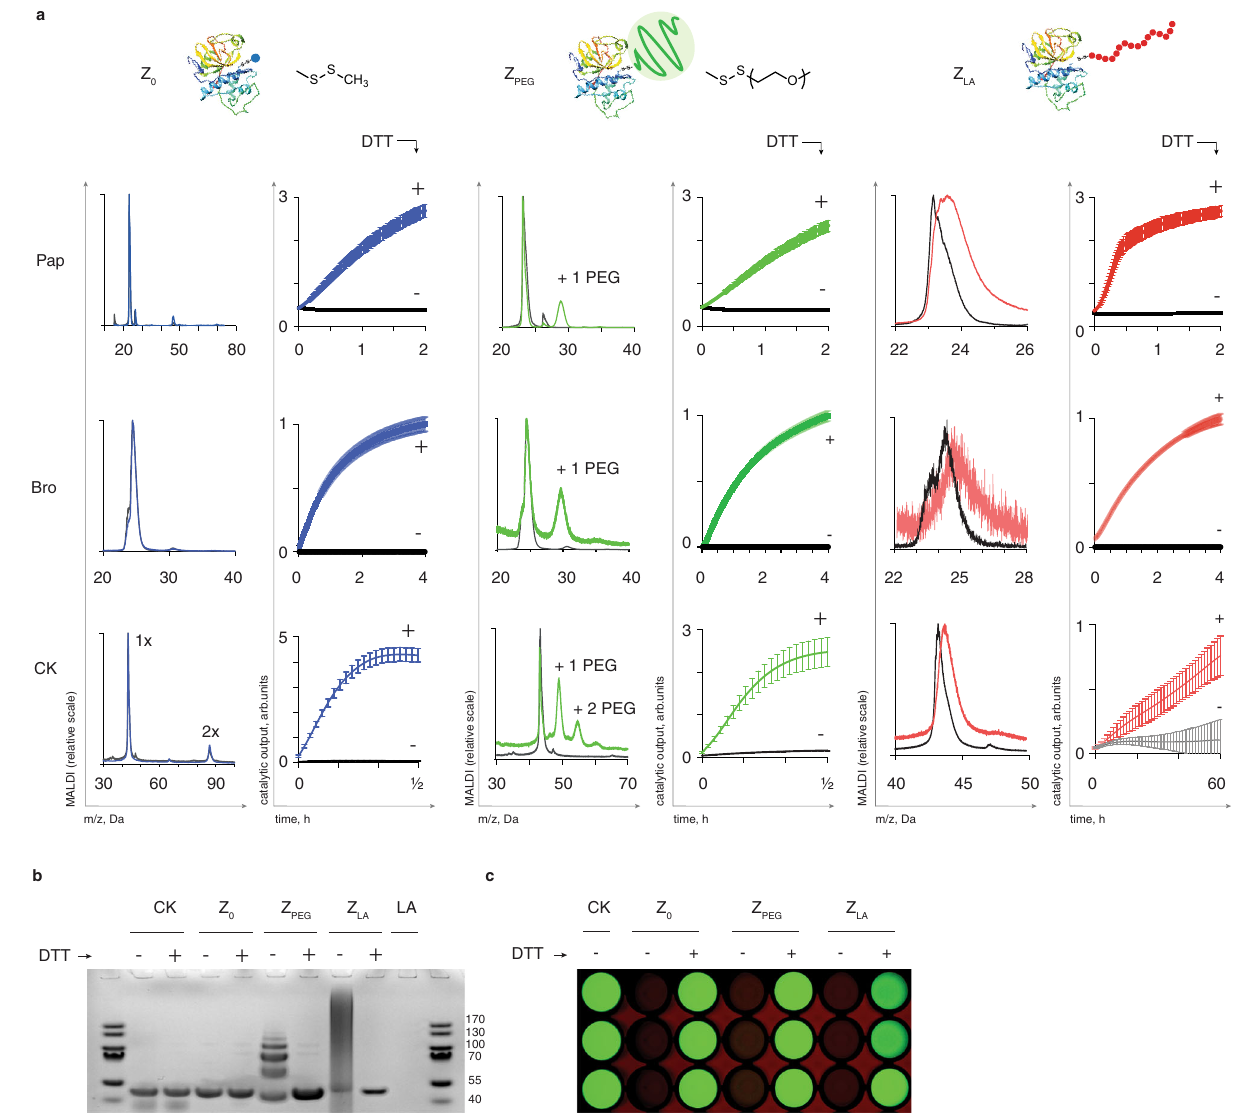
Fig. 3 | Design and characterization of zymogens for cysteinome. a Schematic illustration of the zymogens design, the chemical formulas of the corresponding disul fi des, the reactivation data, and the MALDI characterization data for the zero- length zymogen Z 0 , PEG-based zymogen Z PEG , and the zymogen with the macro- molecular fuse Z LA ; experimental data are shown as mean±S.D. based on three provided visual con fi rmation of the zymogen reactivation for Z 0 , Z PEG, Z